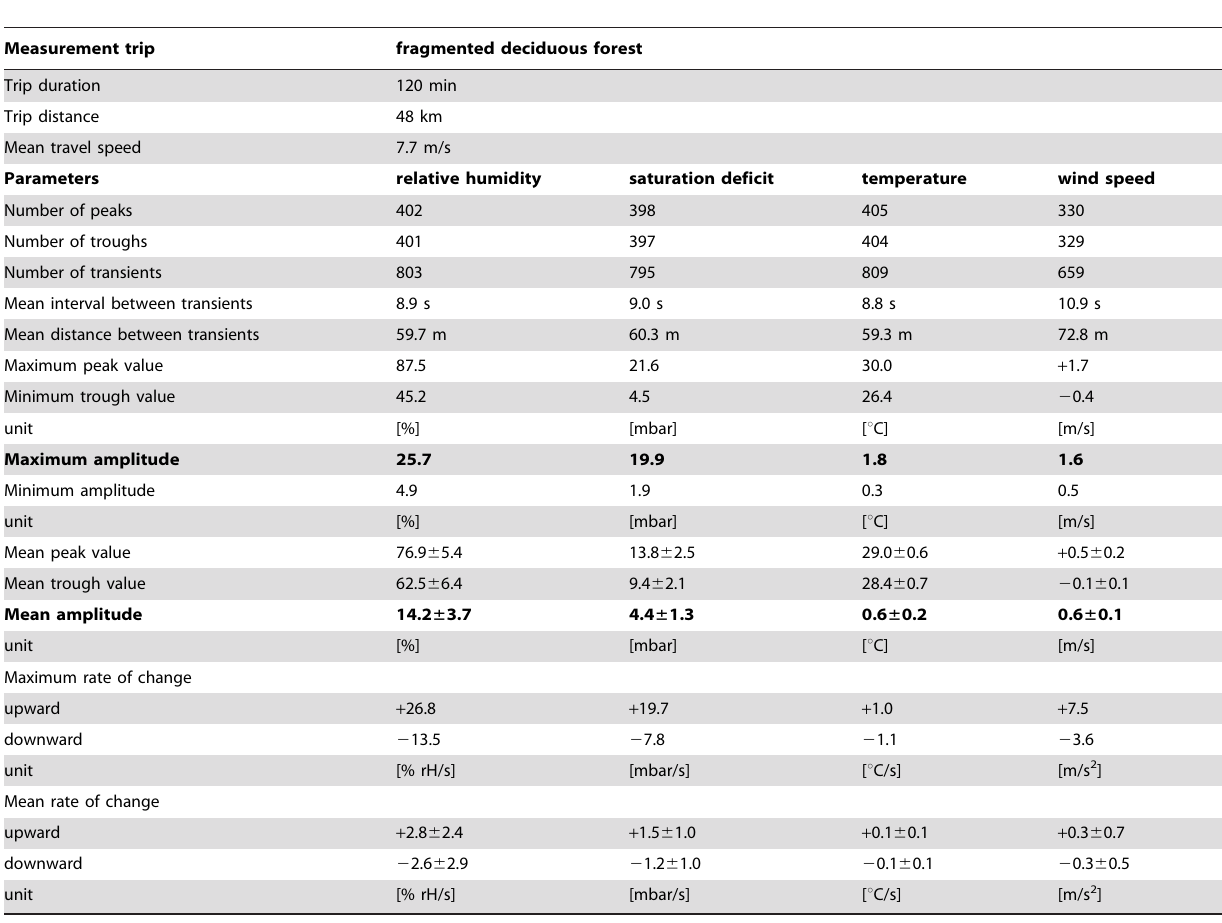
Table 3. Fluctuation statistics of humidity, temperature and wind speed values for a typical measurement trip through a deciduous